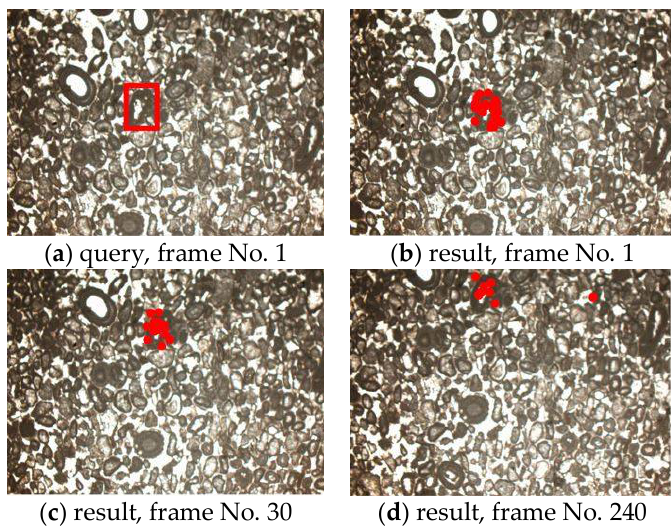
Figure 2. An example of points that meet the criteria of matching the query image and exemplary frames of video sequences for grain tracking, for selected frames numbers (frame No.).